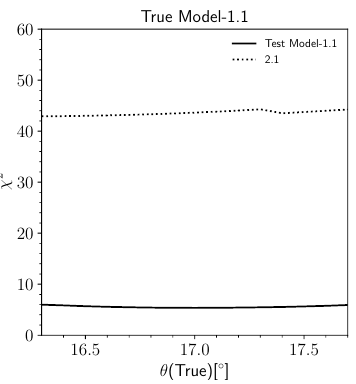
Figure 9 . Comparison between the best one-parameter model (Model 1.1) and the best two- parameter model (Model 2.1) for ESSnuSB using priors. The panel shows the quantity (cid:31) 2 , given Model 1.1 as the true model, as a function of the model parameter (cid:18) in its 3 (cid:27) interval (cid:18) 3 (cid:27) presented in table 8. The value of (cid:31) 2 for Model 1.1 is displayed with a black solid curve (when acting as a min test model), whereas it is marked for Model 2.1 (i.e., the test model) by a black dotted